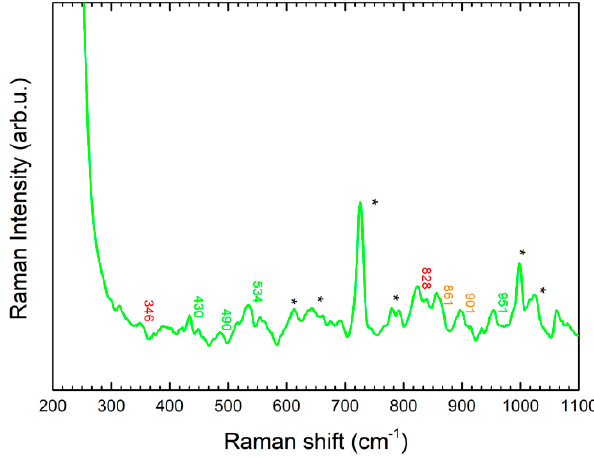
Figure 9. SERS spectrum of a green pigment sample collected from area 3 area with GT-SERS, showing characteristic peaks of emerald green (Green text), chrome orange (red text) and barium yellow (yellow text). Asterisks are indicative of gel substrate peaks.